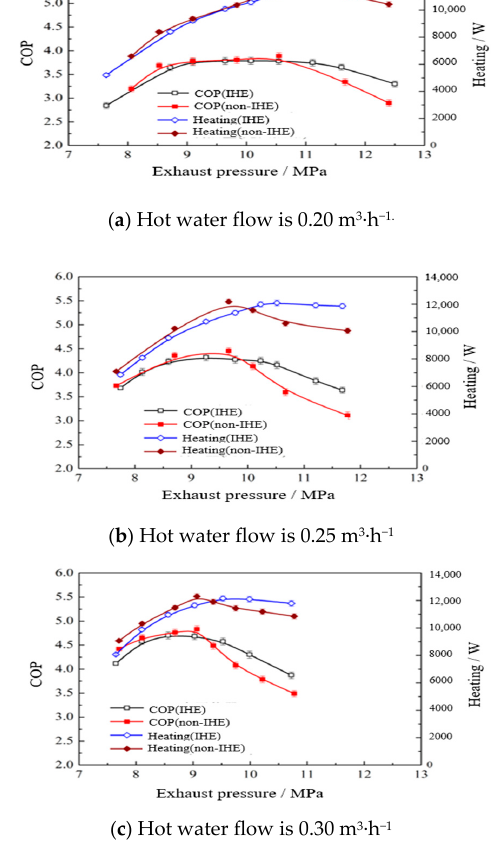
Figure 5. Comparison between heating and COP with and without IHX at different hot water flow